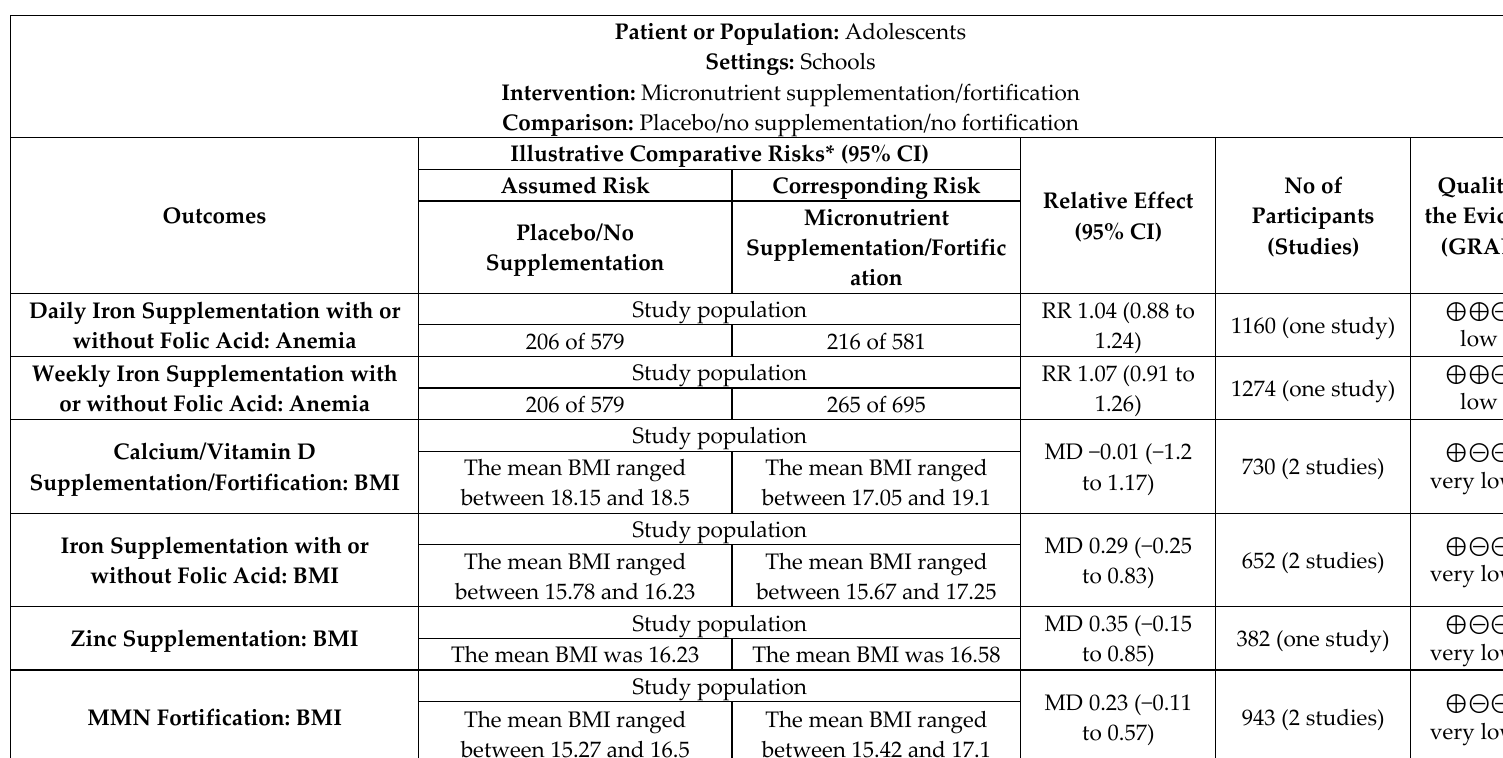
Table 3. Summary of findings.